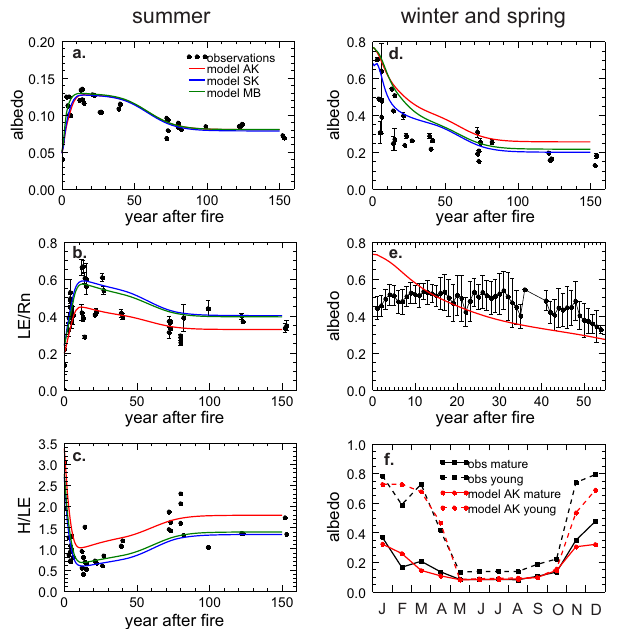
Fig. 3. Comparison of simulated to observed post-fire summer albedo (a) , latent heat (b) , and Bowen ratio (c) , winter and spring albedo (d–e) , and monthly albedo (f) . Observations in (a)–(d) are extracted from Amiro et al. (2006) excluding the Southern Old As- pen site, (e) from Lyons et al. (2008), and (f) from Randerson et al. (2006). Modeled variables from July were chosen for (a)–(c) (observations spanned 26 June–24 July), January and February for (d) (observations spanned 1 January–1 March), and February and March for (e) (observations spanned 2 February–6 April). Modeled grid cells include field sites from Alaska (AK, 63.5 ◦ N, 145 ◦ W), Saskatchewan (SK, 54 ◦ N, 105 ◦ W), and Manitoba (MB, 55.9 ◦ N, 97.5 ◦ W. The young site in (f) includes 3–5yr post-fire, and mature includes approximate 82–84yr. Only broadband albedo is consid- ered. LE = latent heat, H = sensible heat, and R n = net